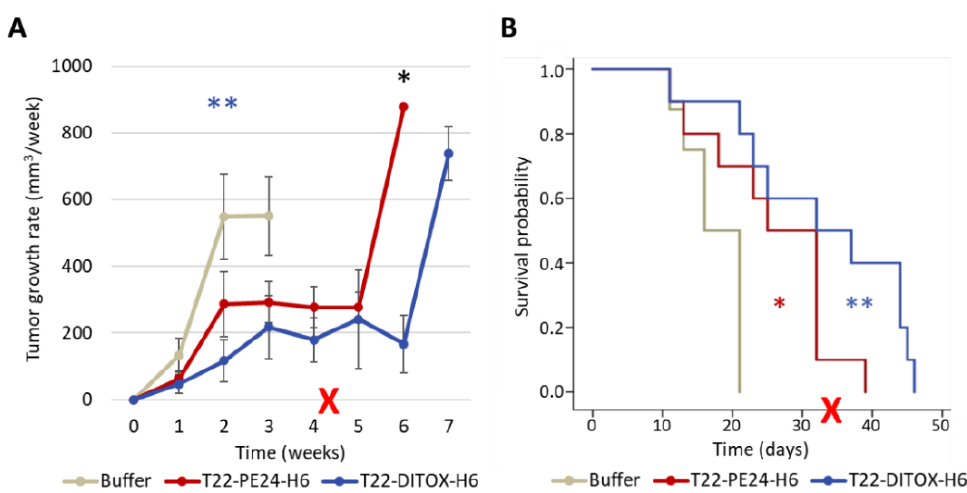
Figure 3. Repeated dose of T22-DITOX-H6 or T22-PE24-H6 treatment inhibit tumor growth and increases survival without systemic toxicity in a CXCR4 + AN3CA subcutaneous EC model. Mice were treated with either buffer, 10 µg T22-DITOX-H6 or 10 µg T22-PE24-H6, 3 times a week, until a maximum of 15 doses. ( A ) Weekly tumor growth rate over time measured in all three groups ** p = 0.005; * p = 0.034 (mean ± SEM; T-test). ( B ) Mouse survival time registered for the buffer and nanotoxin-treated groups. * p = 0.017; ** p = 0.002 (mean ± SEM; Log-Rank test). The red cross indicates the end of treatment doses.